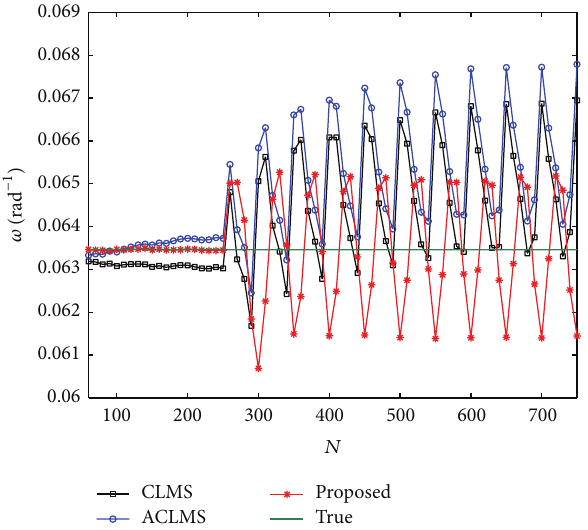
Figure 3: Three channel signals in unbalanced system.